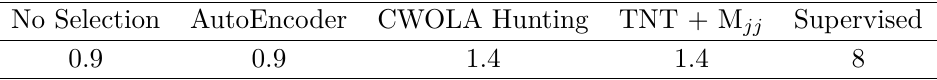
Table 3 . A comparison of the observed significance (in σ ’s) of a bump hunt search using various different classifiers to select events with a 3% efficiency. We also compare to the significance of a bump hunt on events prior to any classifier selection. Except for the supervised, the classifiers were trained on a sample with 0.1% of signal events. All significances are obtained on a validation sample that also has 0.1% signal